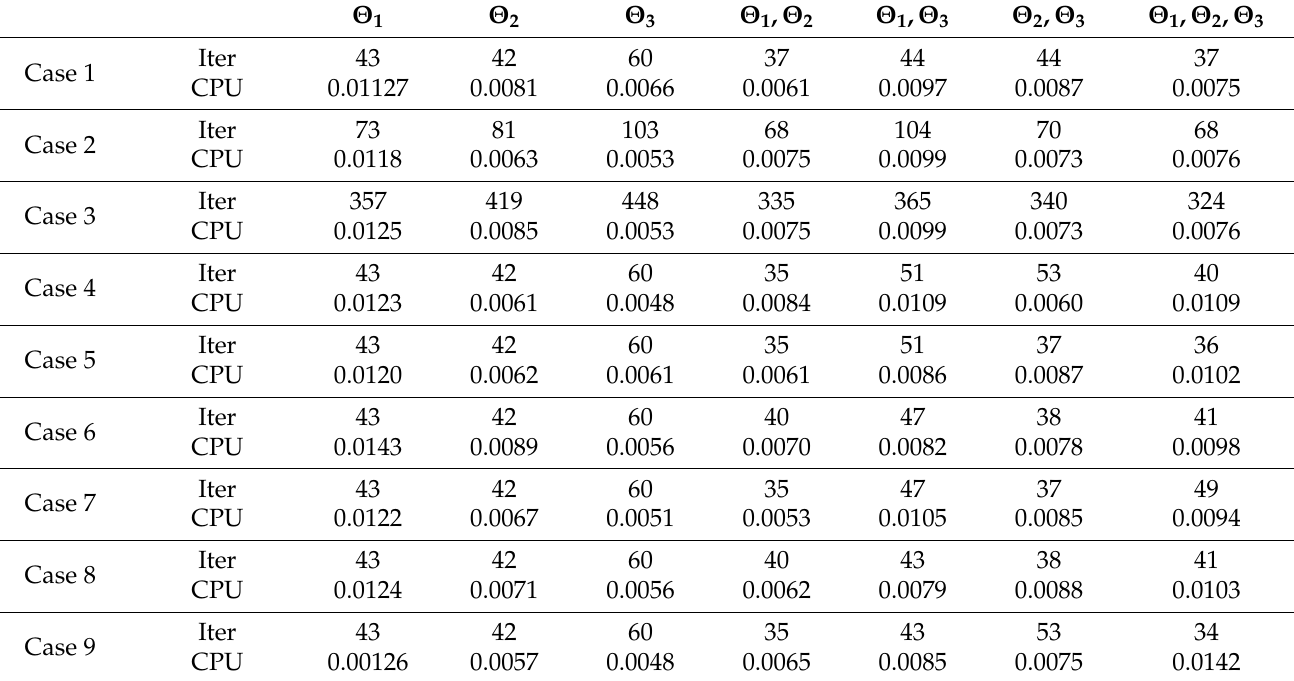
Table 2. The convergence behavior of inputting Θ i , i = 1,2, 3, stop condition (Cauchy error) < 10 − 9